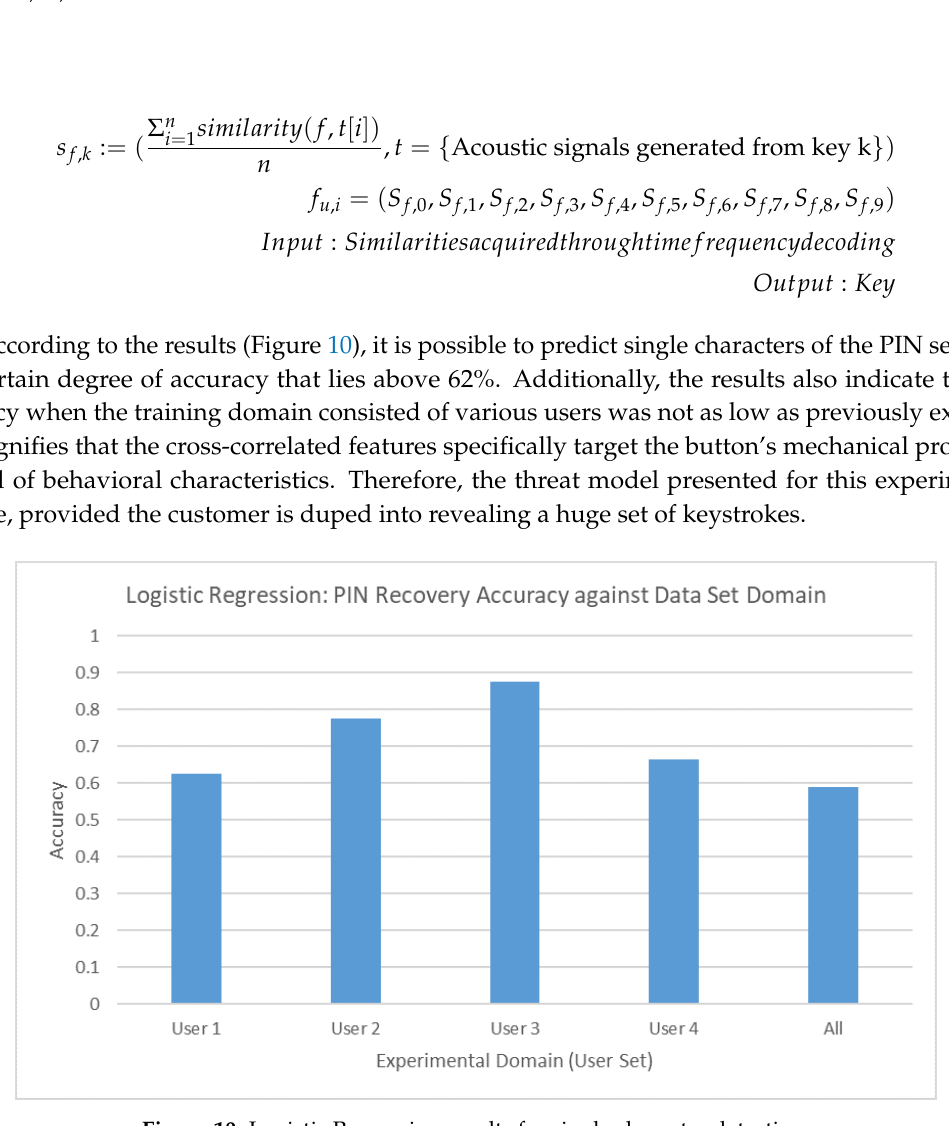
Figure 10. Logistic Regression results for single character